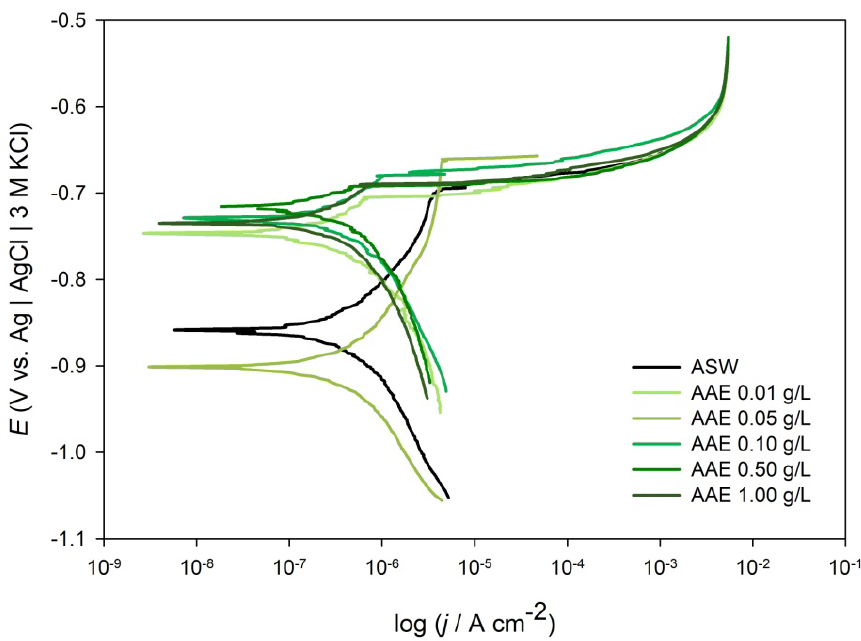
Figure 4. Potentiodynamic polarization curves for the Al alloy 5083 in ASW, containing different concentrations of Artemisia annua L. extract (AAE, shown in figure); ν = 0.5 mV s − 1 . Table 4. Kinetic parameters from polarization measurements and calculated values of surface coverage, θ , and inhibition efficiency, η , for the Al 5083 alloy in ASW without and with the addition of different concentrations of Artemisia annua L. extract (AAE).